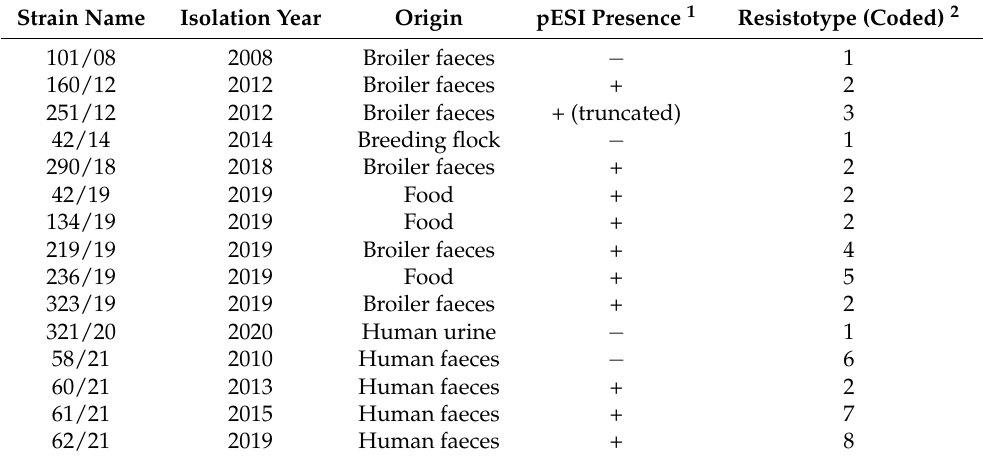
Table 1. Metadata and characteristics of Salmonella Infantis strains used in the study ( n =